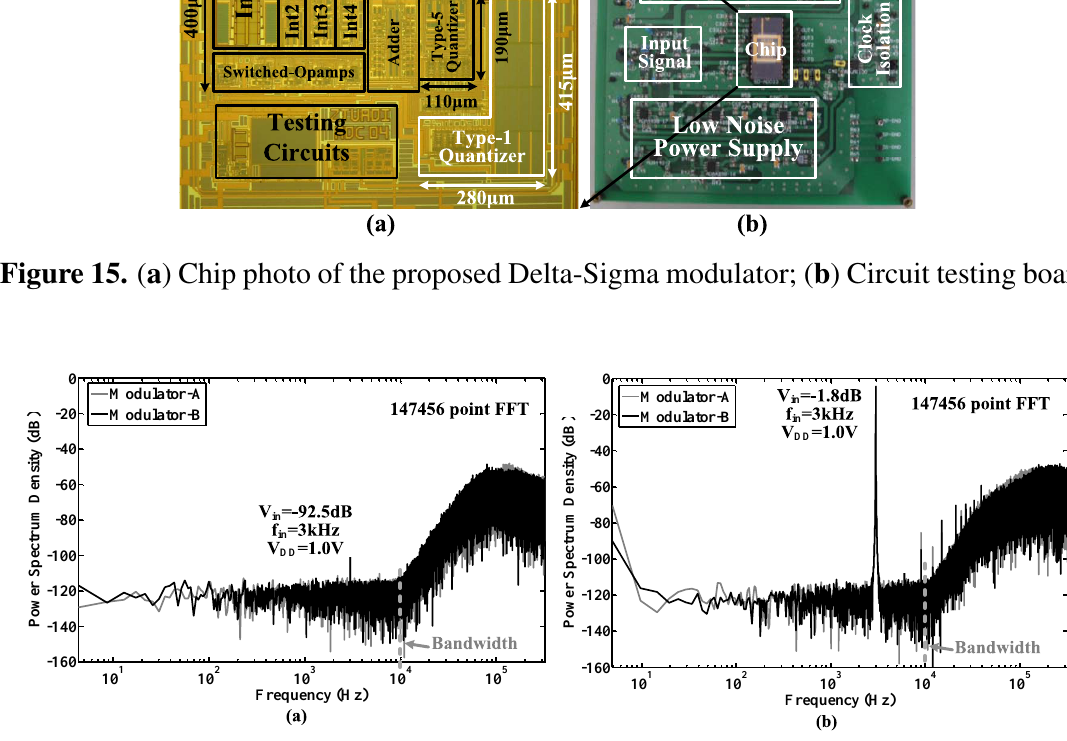
Figure 16. Measured output spectrums of the modulators versus different input amplitudes. ( a ) The input is a − 92 . 5 -dB, 3-kHz sinusoidal waveform with respect to a 1.0-V reference; ( b ) The input is a − 1 . 8 -dB, 3-kHz sinusoidal waveform with respect to a 1.0-V reference.